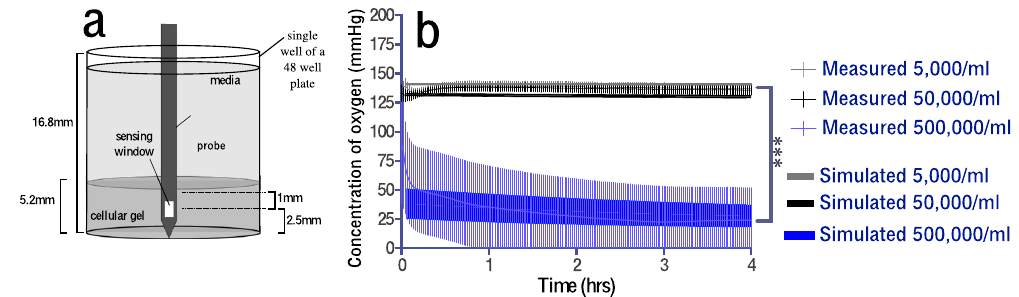
Figure 3. ( a ) The experimental setup, ( b ) the measured dissolved oxygen concentrations and the corresponding simulated dissolved oxygen concentrations for the area equivalent to the sensor window. Simulation error bars are due to repeated simulations (3 per cell density) with variation in the cell density within 10% of stated value, in addition to error caused by averaging over the sensor area. Other parameters values